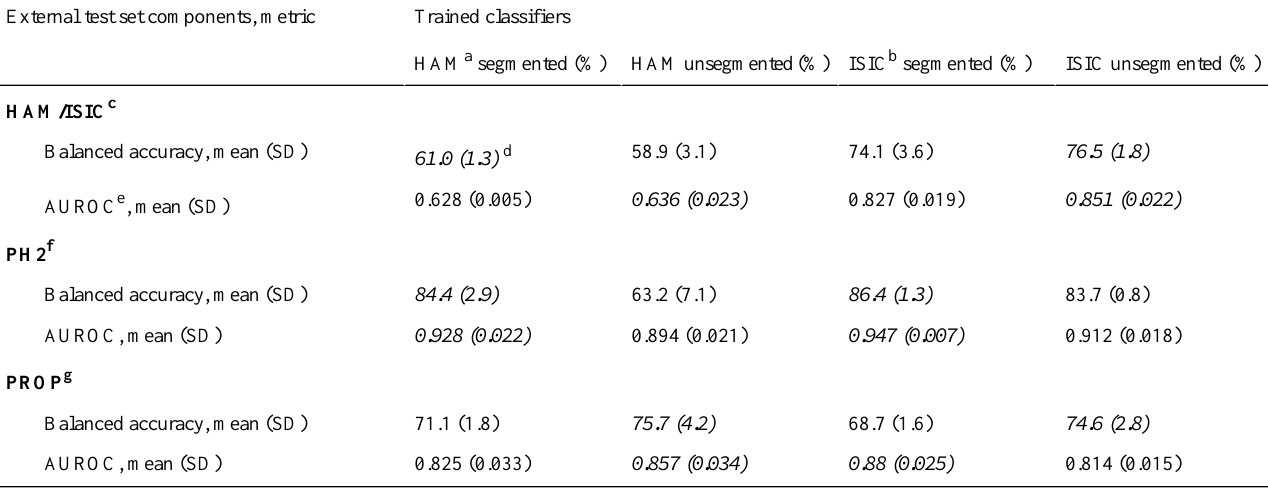
Table 2. Overview of the balanced accuracy and area under the receiver operating characteristic curve for each type of classifier across the external test set’s 3 individual